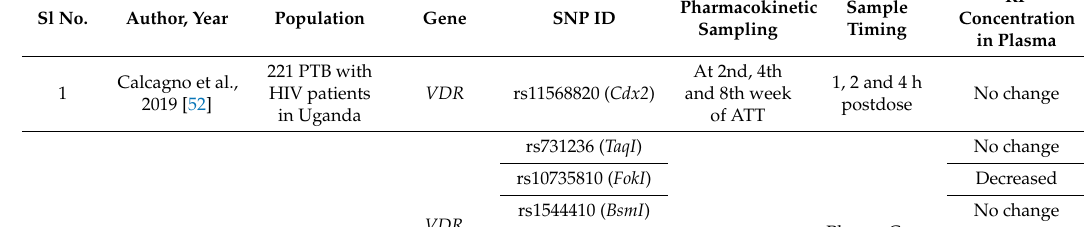
Table 7. Influence of VDR , CYP24A1 and CYP27B1 genetic variants on plasma RF levels. Sl